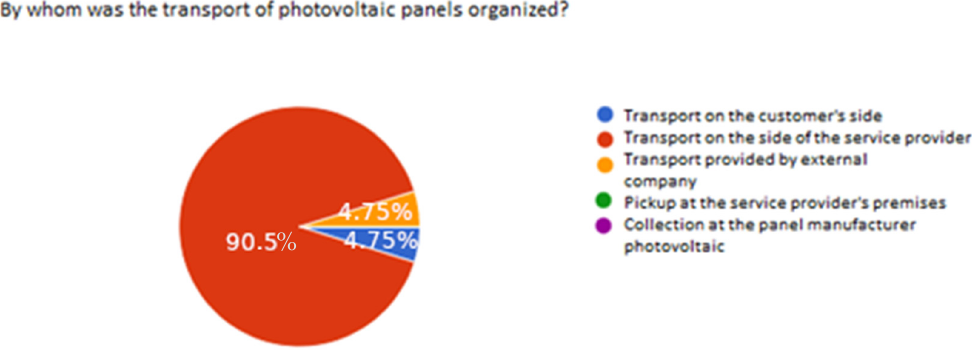
Figure 7. The process of transporting the photovoltaic installation.